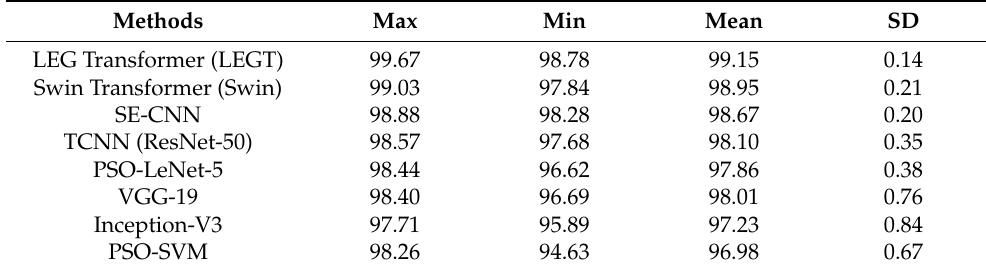
Table 9. The results of the testing dataset in different models